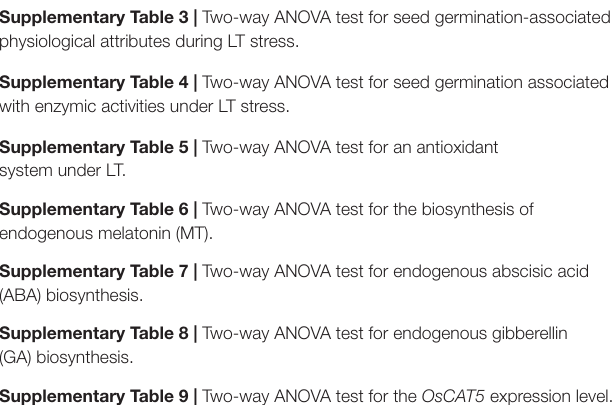
Supplementary Figure 6 | Effects of exogenous MT treatment on endogenous gibberellin (GA) biosynthesis. (A–D) Transcript abundance of GA of catabolic